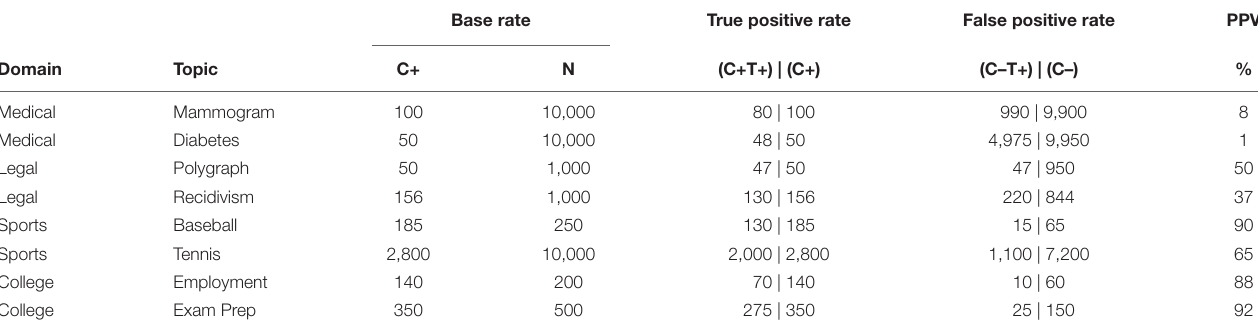
TABLE 3 | Bayesian reasoning problems and relevant